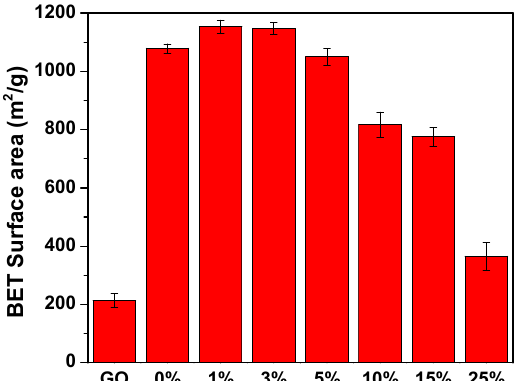
Figure 1. BET surface area of GO, MIL-53(Al) and MIL-53(Al)-GO nanocomposites (n% = MIL-53(Al)- GO nanocomposite with n% mass ratio of GO to MIL-53(Al); 0% = MIL-53(Al)).